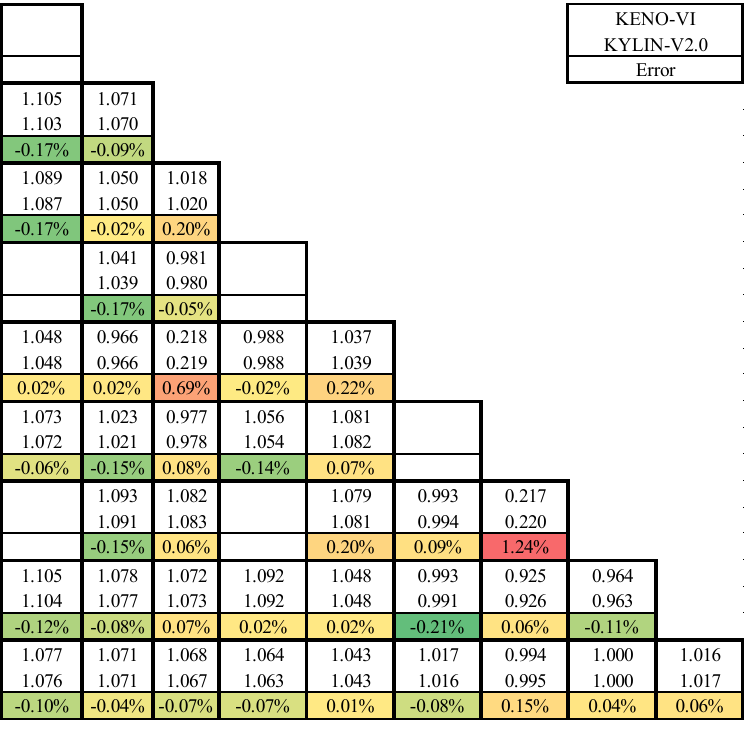
Figure 6. Pin power distribution of problem 2O fuel assembly for VERA